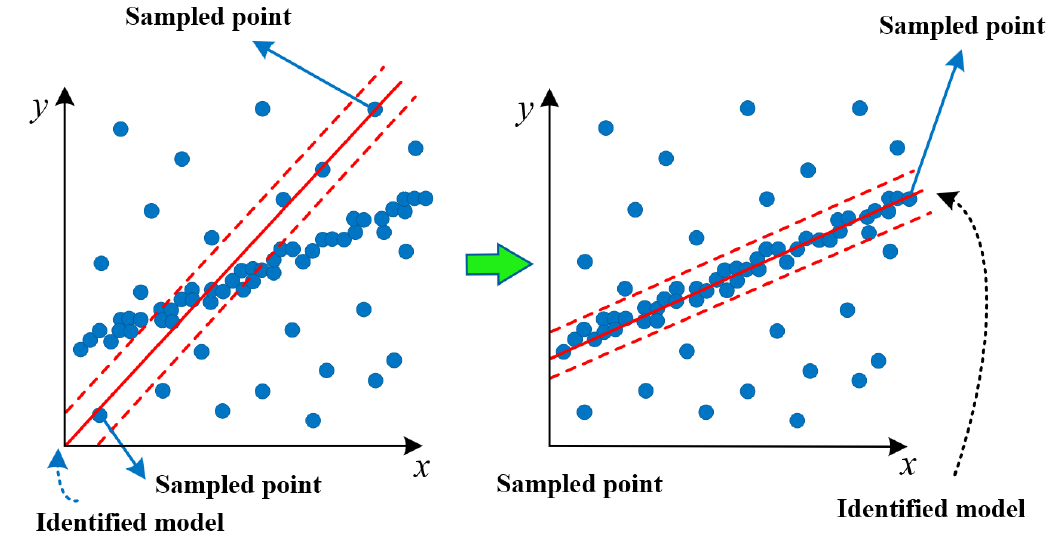
Figure 5. Conceptual of Random Sample Consensus.